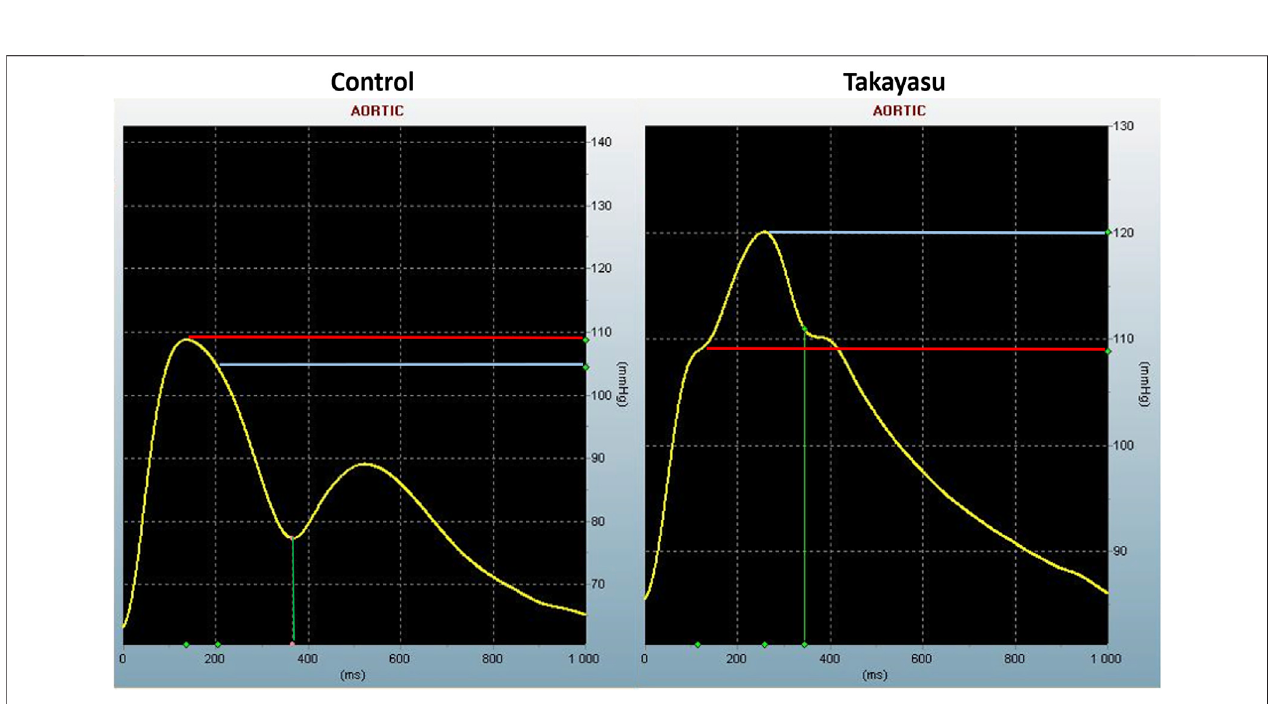
FIGURE 2 | Aortic pulse wave analysis. Pulse pressure waveform from one of the healthy controls demonstrating re fl ecting wave during late systole, and from a Takayasu patient without proximal stenosis, where re fl ecting wave during early systole produces an augmented systolic pressure. The difference between red and blue line is the augmented pressure (the difference between the second and fi rst systolic peak pressure). mmHg, millimeter of mercury; ms, millisecond.